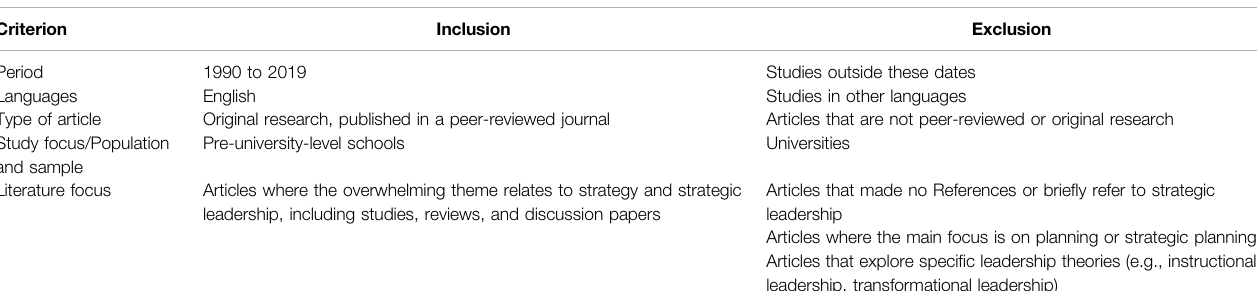
TABLE 2 | Inclusion and exclusion